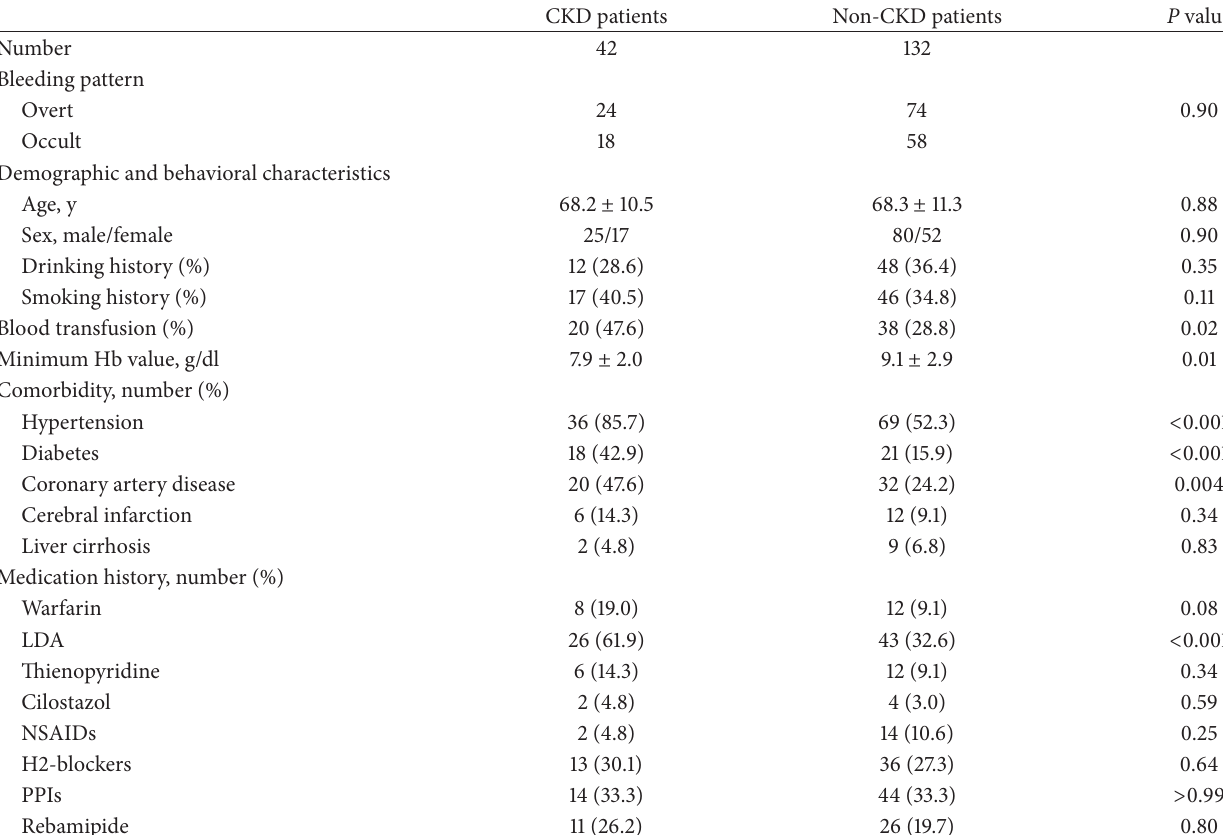
Table 1: Demographic and clinical characteristics of the CKD and non-CKD patients. CKD